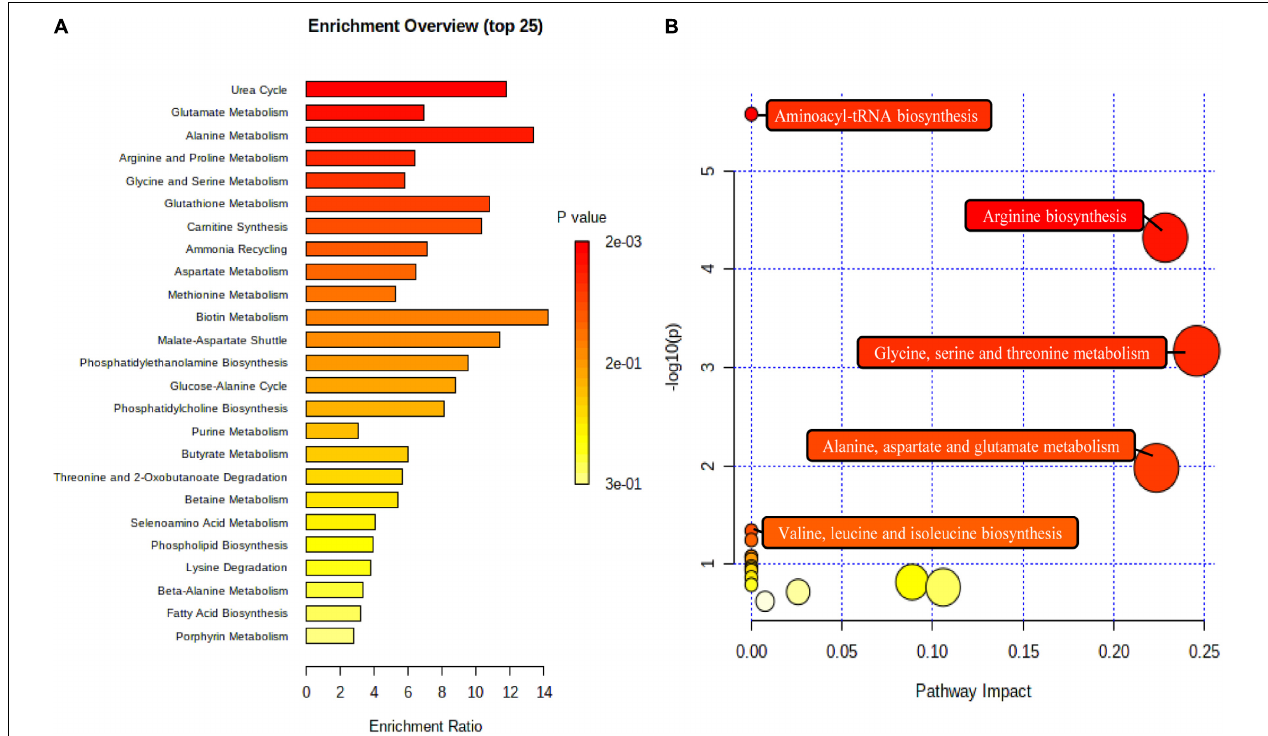
FIGURE 7 | The metabolome view above shows all matched pathways according to p values from pathway enrichment analysis (A) and pathway impact values from pathway topology analysis (B) . The bubble size is proportional to the impact of each pathway and the bubble color denotes the significance, from highest in red to lowest in